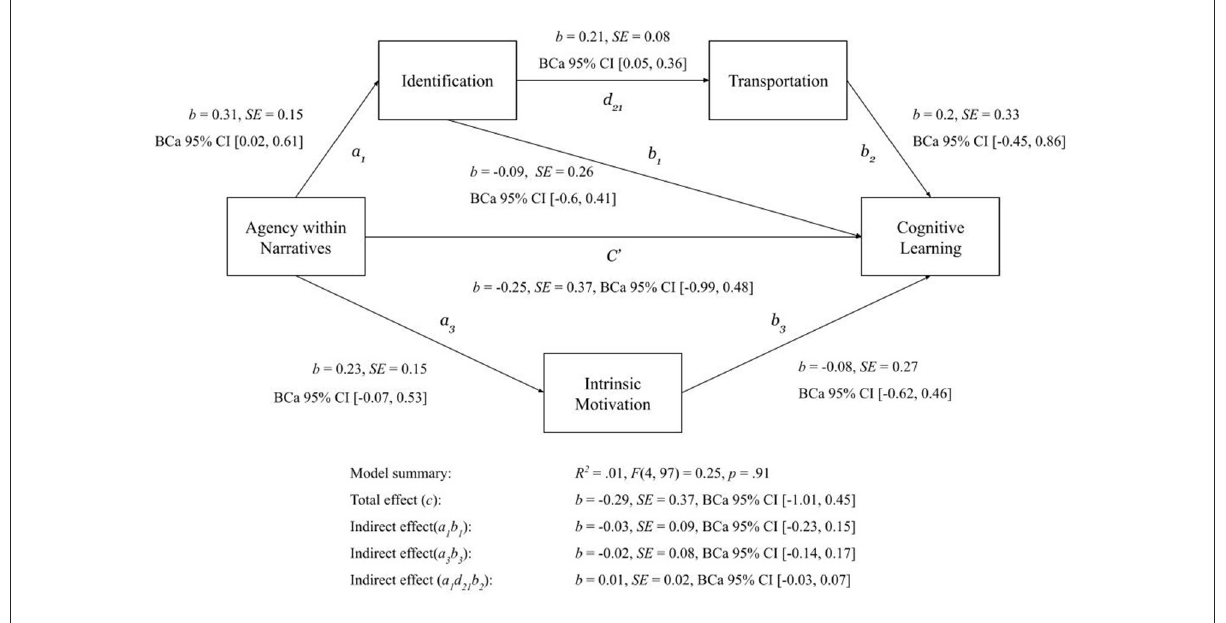
FIGURE3 Mediation analysis experiment 2–cognitive